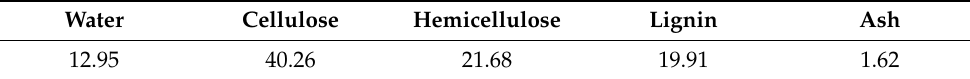
Table 9. Biochemical composition of beech wood feedstock (%)